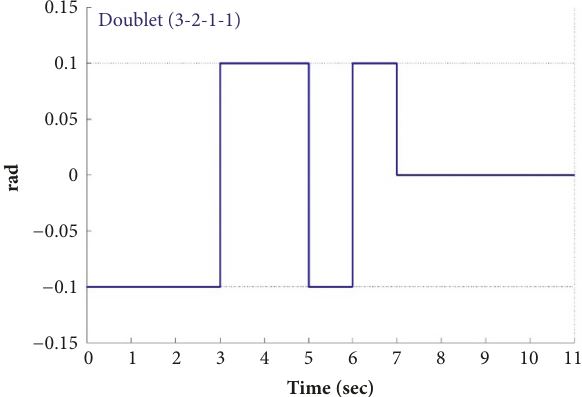
Figure 2: Doublet (3-2-1-1) persistent excitation